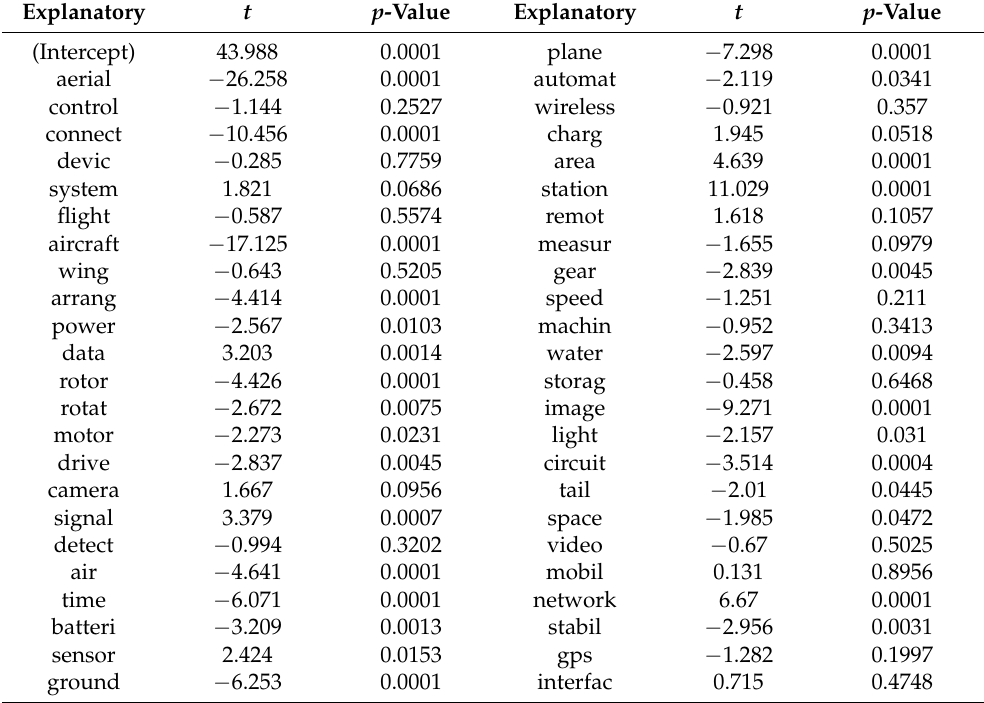
Table 5. Testing results of drone keywords in linear model (response =